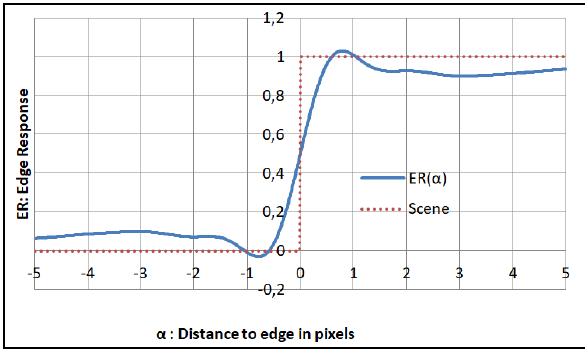
Figure 2. Edge response with MTFC sharpening (G =